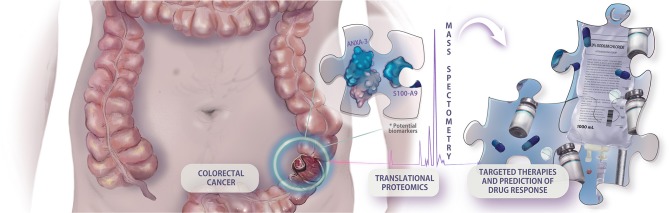
Example of hypothetical application of translational proteomic research in colorectal cancer approach. The prospection of new predictive biomarkers is cardinal to the implementation of an integrative and personalized medicine, making possible the individual assessment of targeted therapies, and drug response.